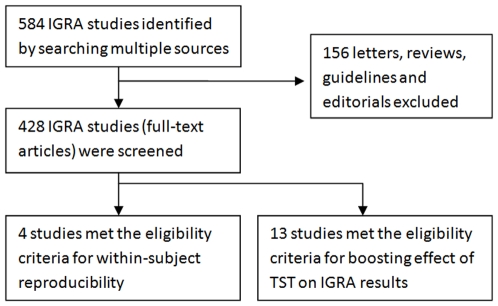
Study selection flow chart.